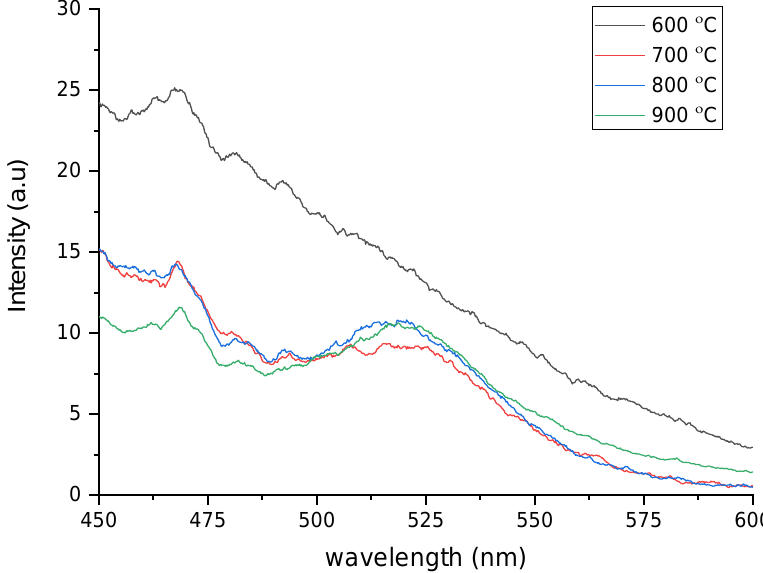
Figure 6. Photoluminescence (PL) spectra of 55ZnO–5B 2 O 3 –40SLS sample sintered at various heat-treatment temperatures.